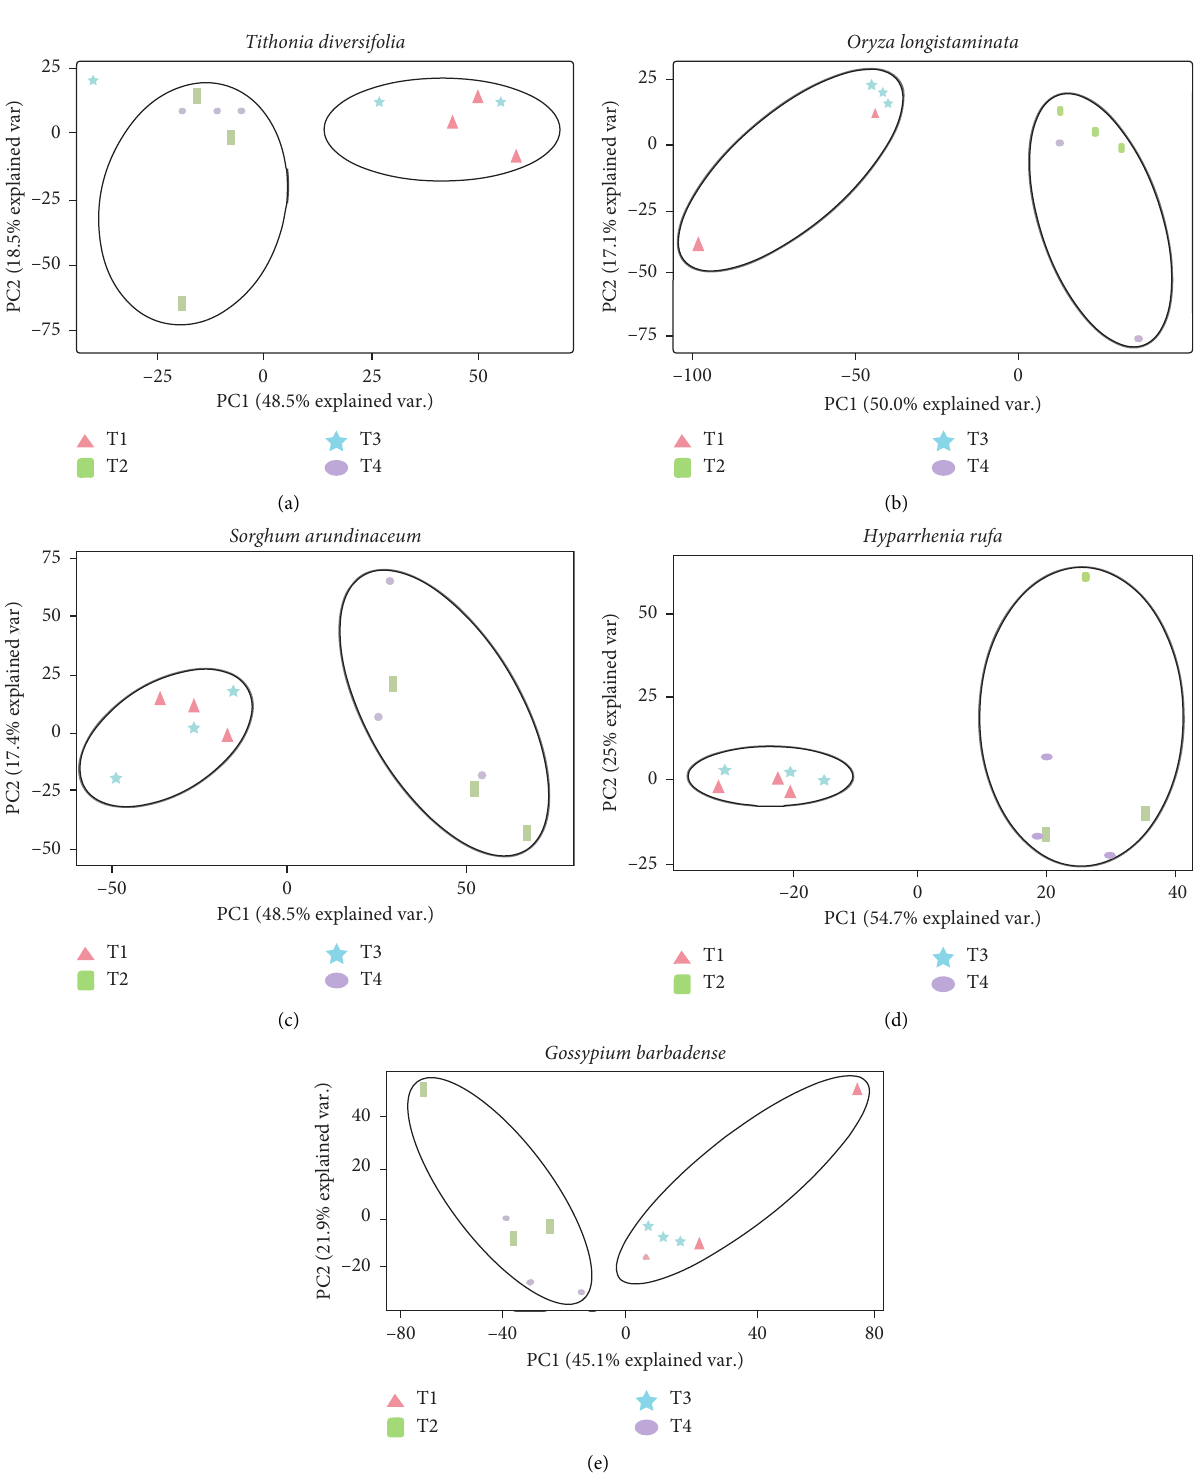
Figure 5: Principal component analysis of bacterial communities across different phytoremediation species growing under different treatments (T1, plant species only; T2, plant species and hydrocarbon; T3, plant species and manure; T4, plant species, manure, and